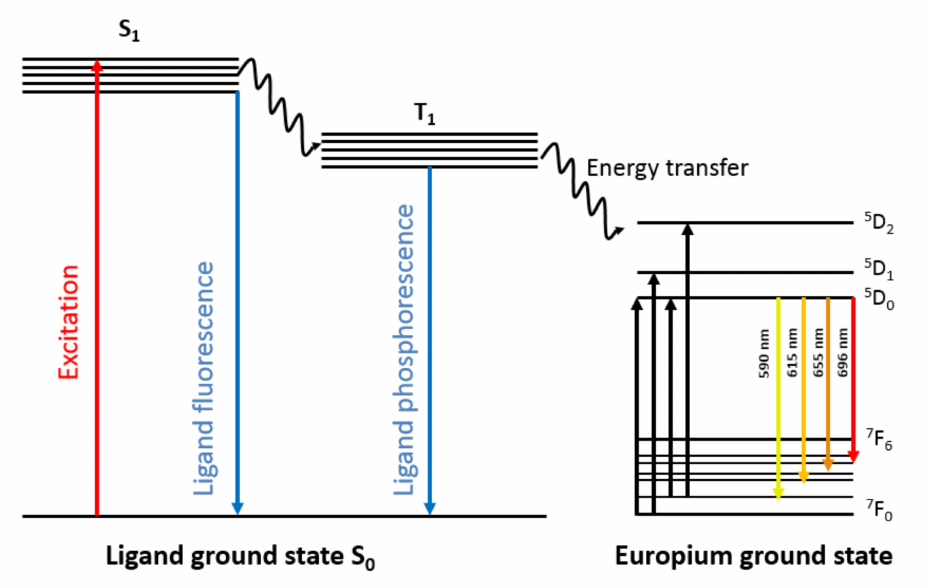
Figure 1. Schematic representation of the fluorescence emission processes occurring in responsive Eu 3+ complex. The ligand absorbs the UV light and is excited from ground level S 0 to S 1 level after transfer of energy to the 5D n level in the Eu 3+ . The ion emits fluorescence as a result of intramolecular energy transfer from 5D 0 level to one of the lower energy 7F